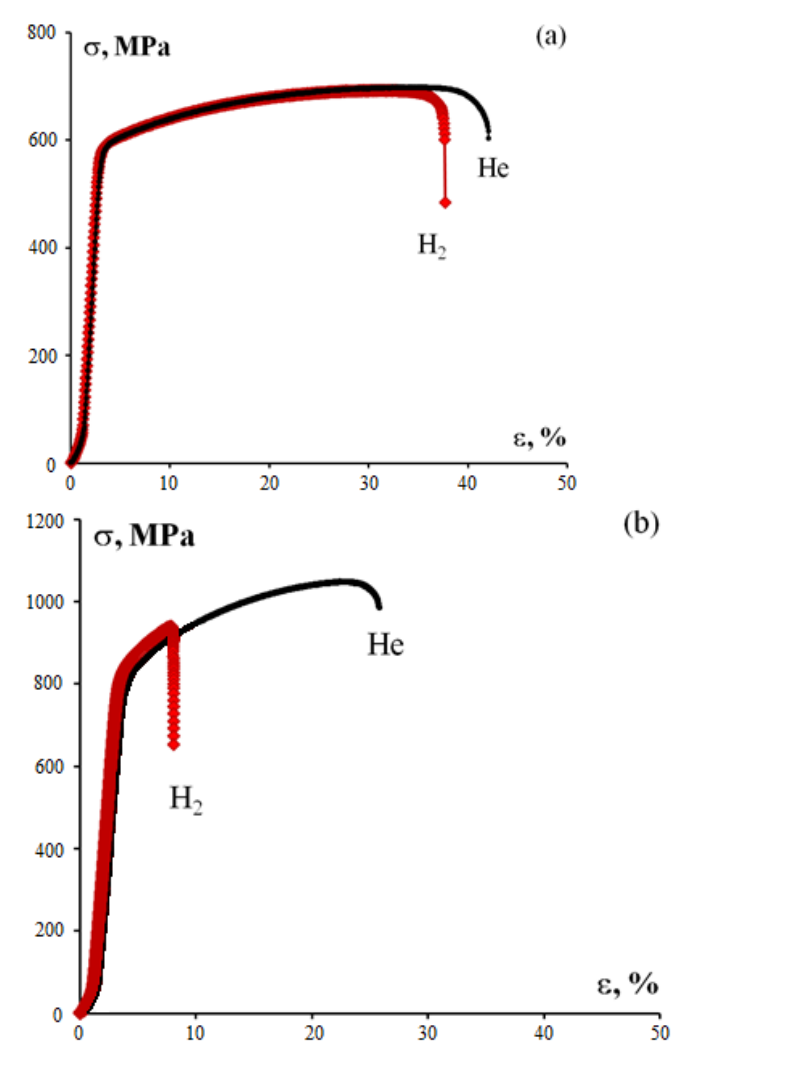
Table 3. Tensile tests results for SLM 316L steel in hydrogen and in helium.